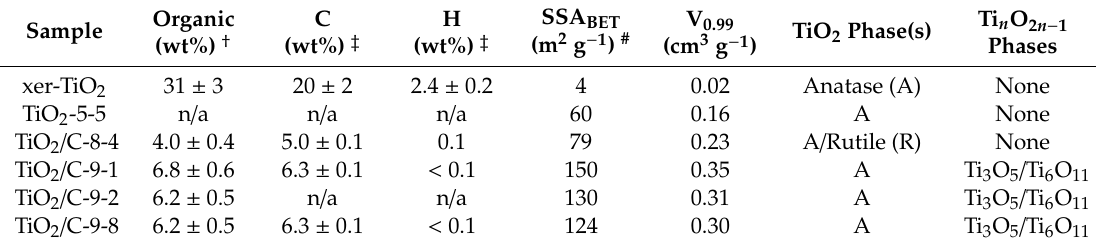
Table 1. Chemical composition, textural and structural properties of xer-TiO 2 , TiO 2 -5-5 and the di ff erent TiO 2 / C- x - y samples.